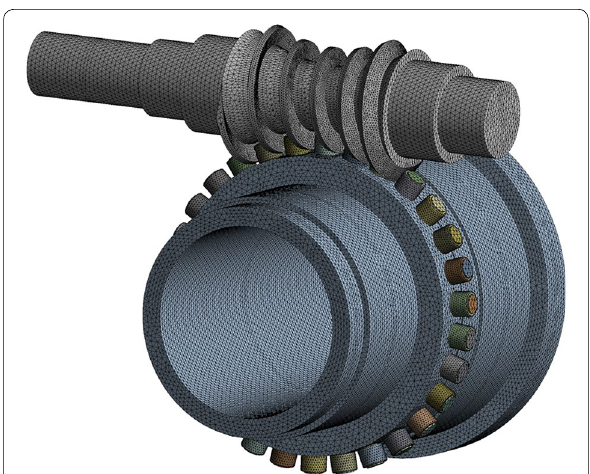
Figure 8 Meshing of the steady-state thermal analysis model